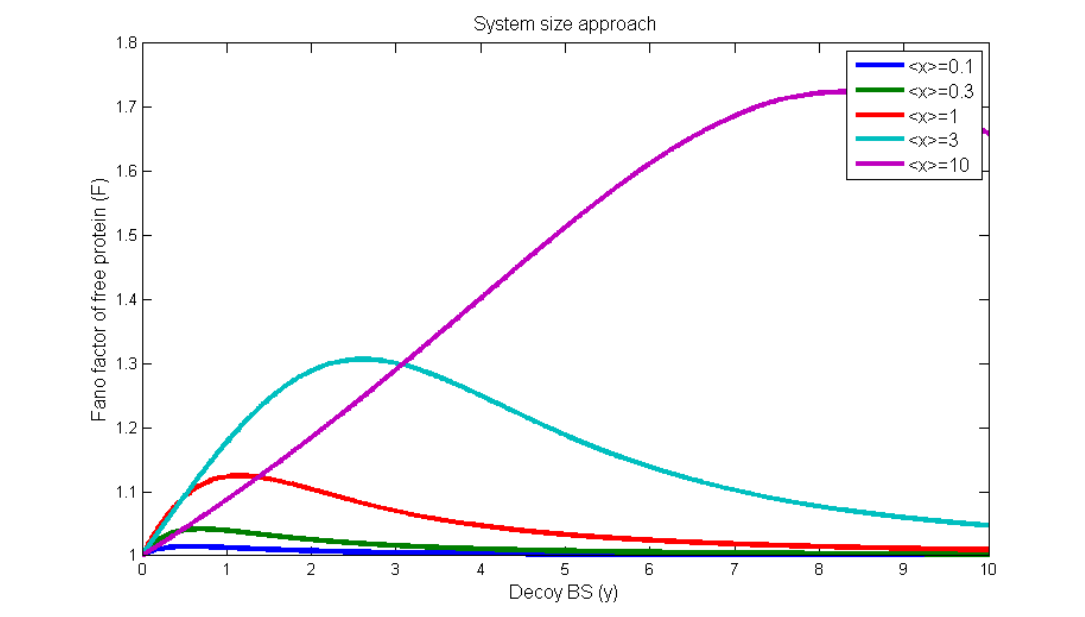
Fig. 5: Fano factor for large system